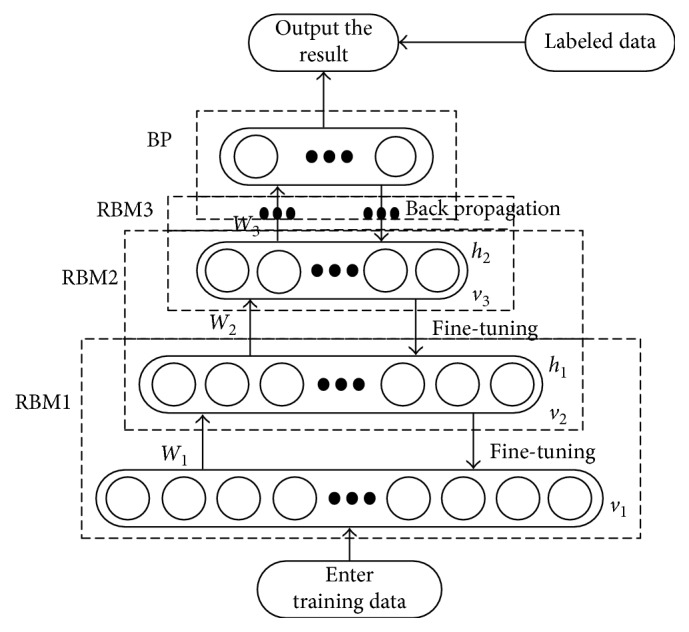
DBNs training flow chart.